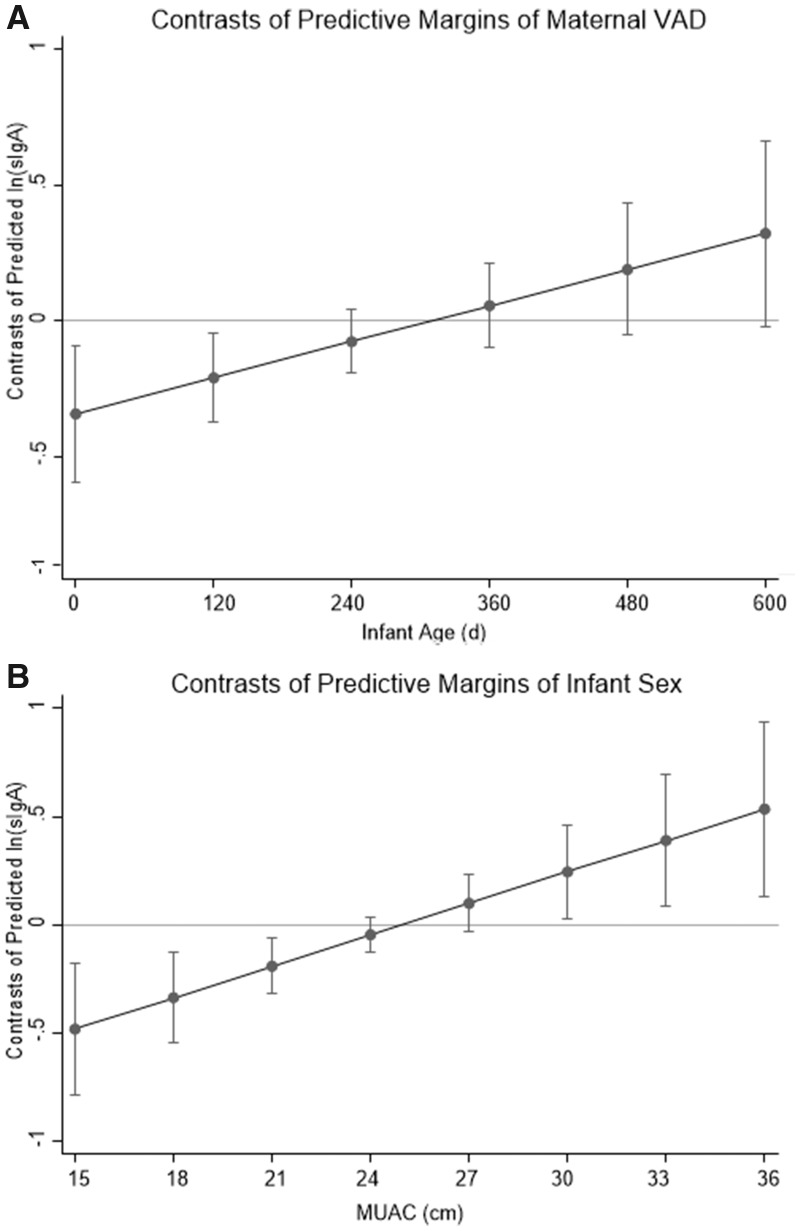
Contrasts of predicted sIgA (ln-transformed) between groups. (A) The difference between the predicted value for mothers without and with VAD (replete–deficient) across the infant age range. Milk from VAD mothers with younger infants (<150 days) was lower in sIgA concentration than VA replete mothers, but VAD mothers with older infants had milk sIgA comparable to VA replete mothers. (B) The difference between the predicted value for mothers with female and male infants (female–male) across the MUAC range. At lower MUAC, milk from mothers of male infants was lower in sIgA than milk from mothers of female infants; but, at higher MUAC, milk from mothers of male infants was higher in sIgA than milk from mothers of female infants. (The horizontal line at the value zero represents the equality of predictions between groups.) sIgA secretory immunoglobulin A; VAD vitamin A deficiency; MUAC mid-upper arm circumference